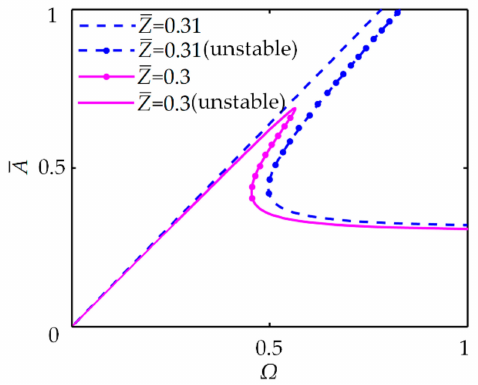
Figure 8. Bounded and unbounded frequency response curve (FRCs) of the quasi-zero sti ff ness (QZS) vibration isolator with di ff erent